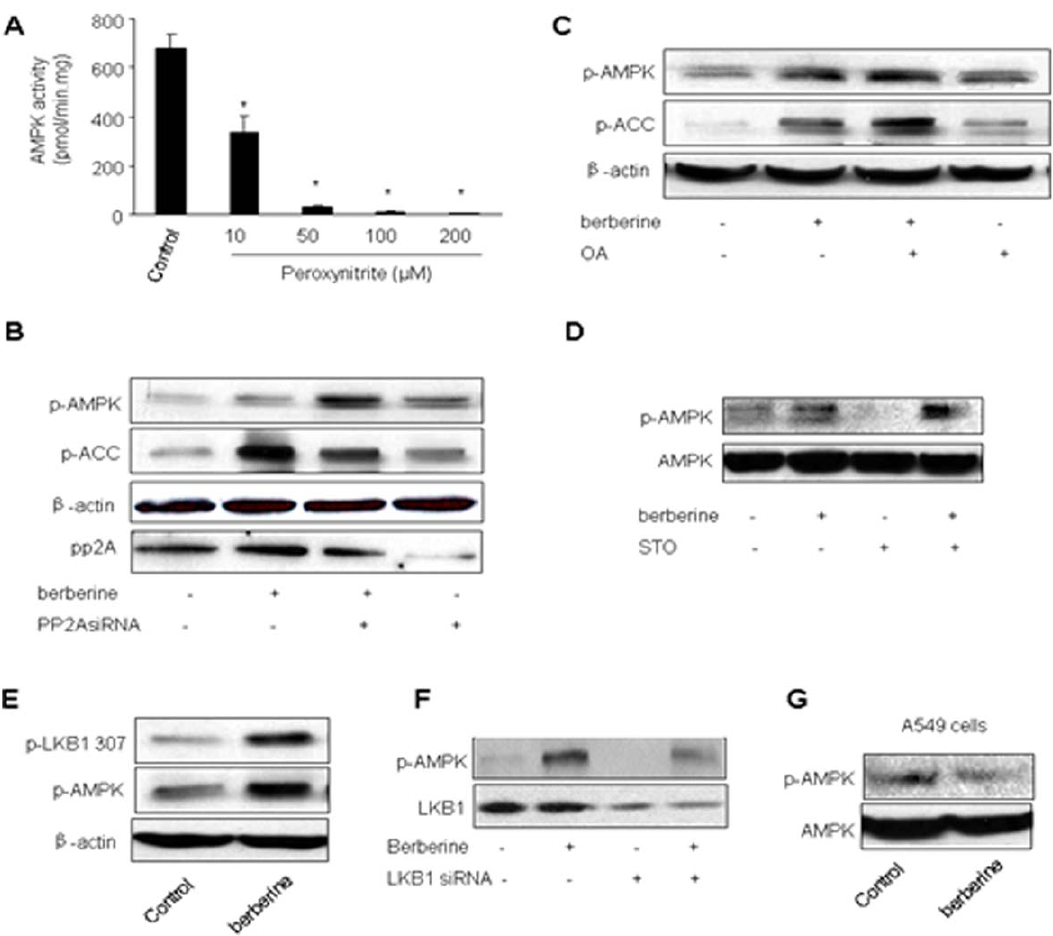
Figure 6. Increased LKB1 Serine 307 phosphorylation by Berberine in BAEC. A. Inhibition of AMPK activity by ONOO 2 . Recombinant AMPK a 1 b 1 c 1 was treated with chemically synthetized ONOO- at concentrations indicated for 5 minutes and AMPK activity was assayed as described in Methods and Materials. N=5 *P , 0.05; control verse ONOO 2 -treated; B . Effects of okadaic acid (OA) on Berberine-enhanced phosphorylation of AMPK-Thr172 and ACC-Ser79 in BAEC. The blot is representative of three blots. from three individual experiments. C . Effects of transfection of PP2A siRNA on Berberine-enhanced phosphorylation of AMPK-Thr172 and ACC-Ser79 in BAEC. The blot is representative of three blots from three individual experiments. D . Effects of STO-609 on Berberine-enhanced phosphorylation of AMPK-Thr172 and ACC-Ser79 in BAEC. The blot is representative of three blots. E. Effects of berberine on the phosphorylation of LKB1 serine 307 in BAEC. The blot is representative of three blots from three individual experiments. F . Genetic inhibition of LKB1 abolishes Berberine-induced phosphorylation of AMPK-Thr172 in BAEC. The blot is representative of three blots from three individual experiments. G Effects of Berberine on AMPK phosphorylation at Thr172 in LKB1-deficient A549